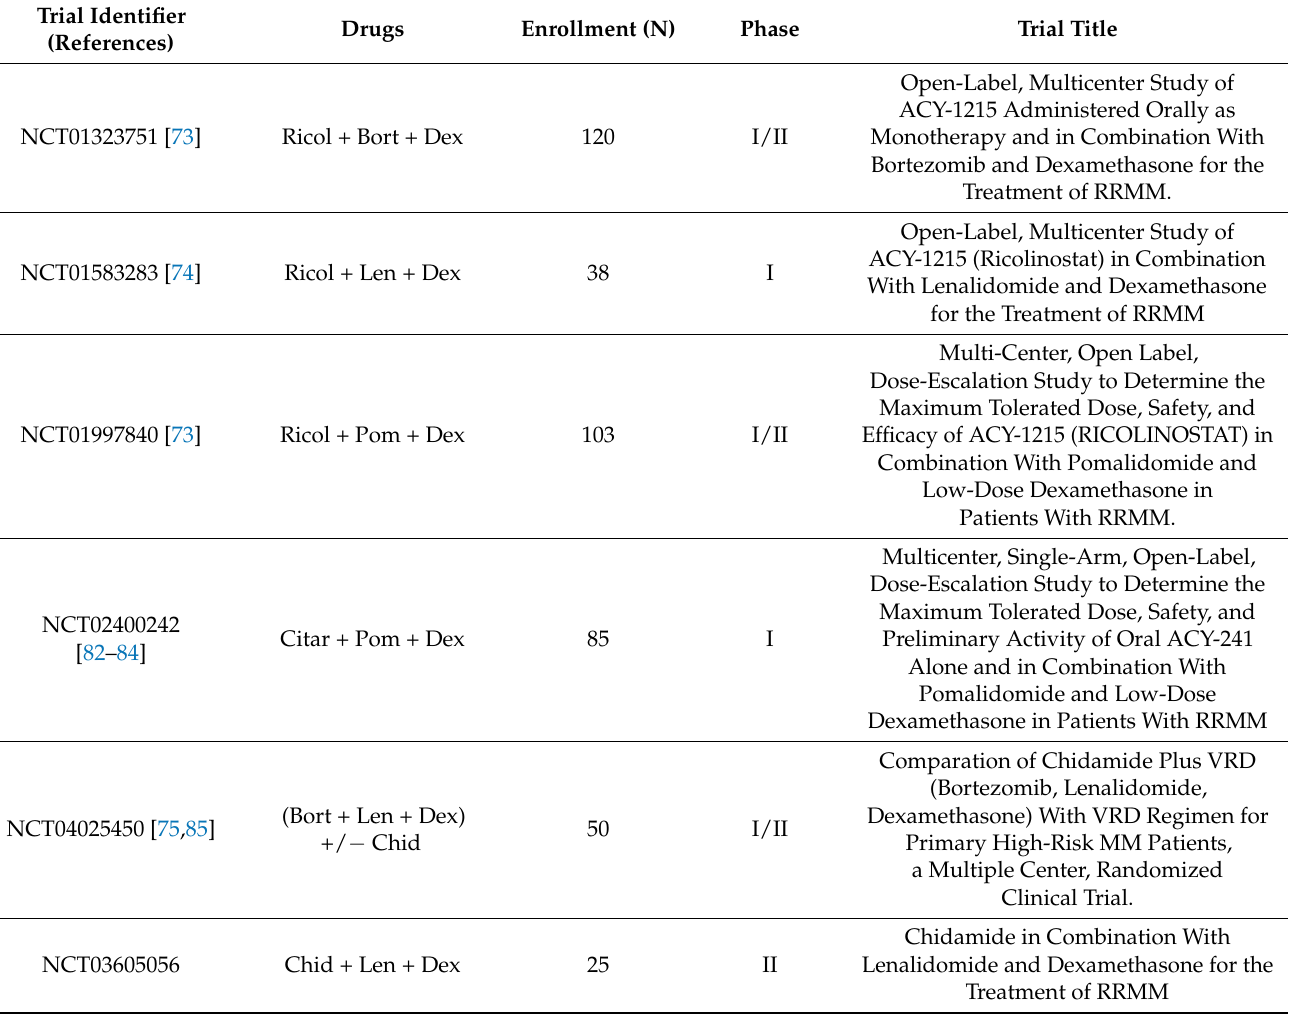
Table 3. Selected Myeloma-based Trials of Isotype-selective HDAC